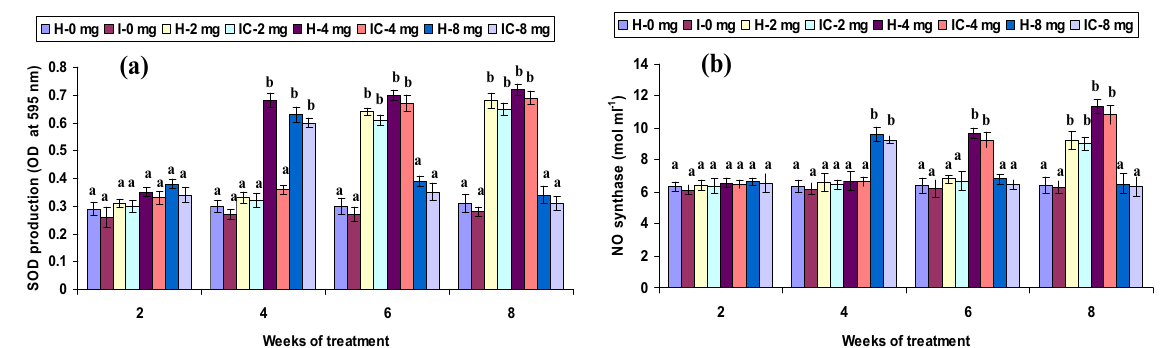
Figure 2. ( a ) Superoxide anion (SOD) radical production and ( b ) nitric oxide (NO) synthase of catla (n = 6) head kidney leucocytes against A. hydrophila . H healthy, I infected. Data are expressed as mean ± SD and the statistically significant difference ( P < 0.05) between mean values as indicated in different letters in each